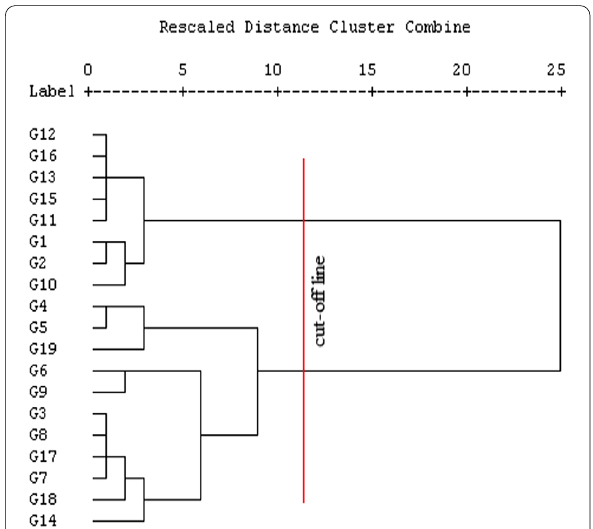
Fig. 4 Dendrogram showing hierarchical classification of 19 investigated barley genotypes based on their ranks for grain yield and stability statistics using Ward’s